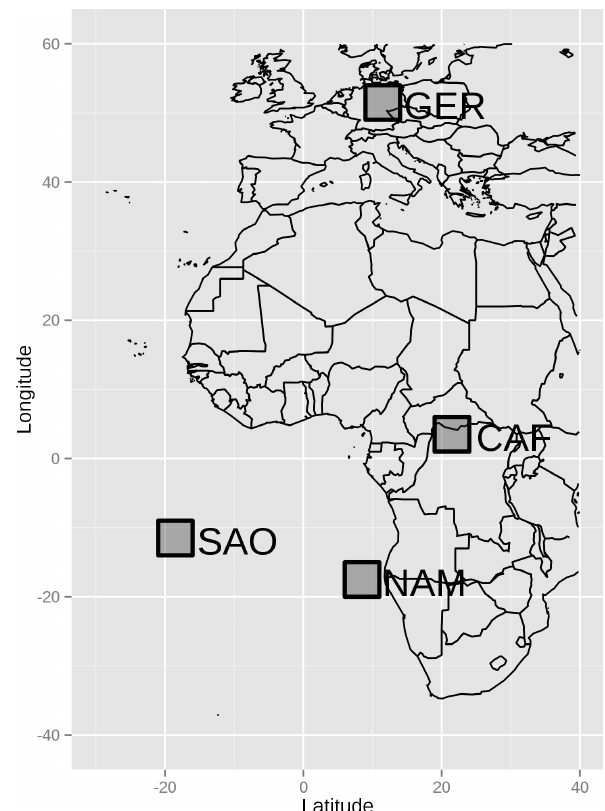
Figure 5. Map showing four regions where level-2-based com- parisons between FAME-C and MODIS-Terra cloud properties are conducted for the years 2007–2009. SAO: southern Atlantic Ocean; NAM: coast of Namibia; CAF: central Africa; GER: Germany.